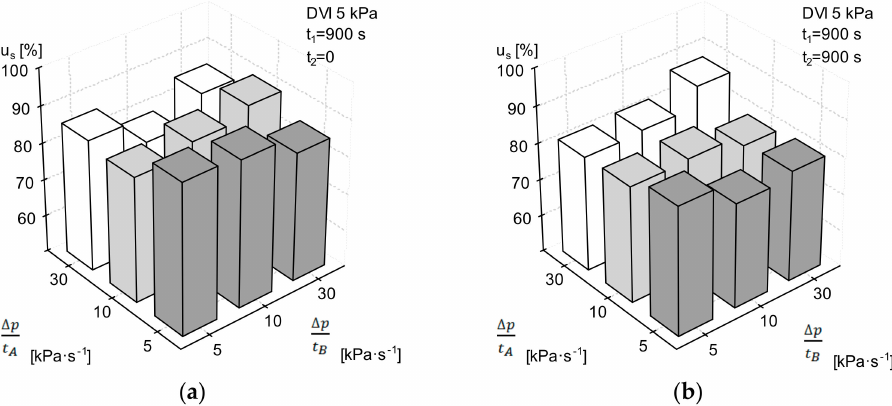
Figure 4. Dependence of the percentage of apple tissue staining u S on the pressure change rate in the DVI cycle, for t 1 = 900 s and di ff erent values of t 2 : ( a ) t 2 = 0 s, ( b ) t 2 = 900 s. For time values t 1 = t 2 = 0, the percentage of apple tissue staining in the dry impregnation process ∆ p = 30 kPa · s − 1 and ∆ p = 5 kPa · s − 1 to 86.8% for ∆ p = 30 kPa · s − 1 and ∆ p = (DVI) ranged from 79.5% for t A t B t A t B − 1 30kPa · s (Figures 3 and 4). The standard deviations of the tested value in this experimental cycle ranged from 3.7% to 17.5%. The highest degree of apple tissue staining, i.e., 87.4%, was noted at the ∆ p = ∆ p = 30 kPa · s − 1 maximum values of t 1 and t 2 and for t A t B